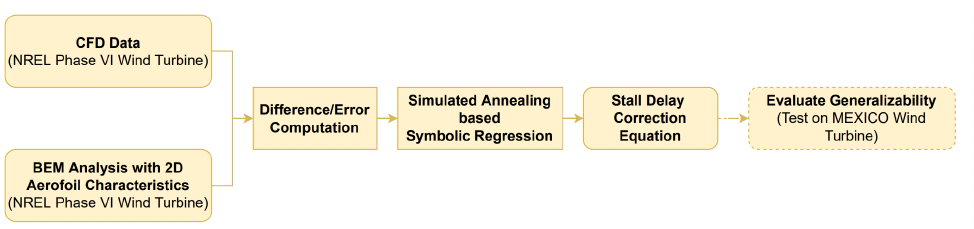
Figure 5. Flowchart describing overall